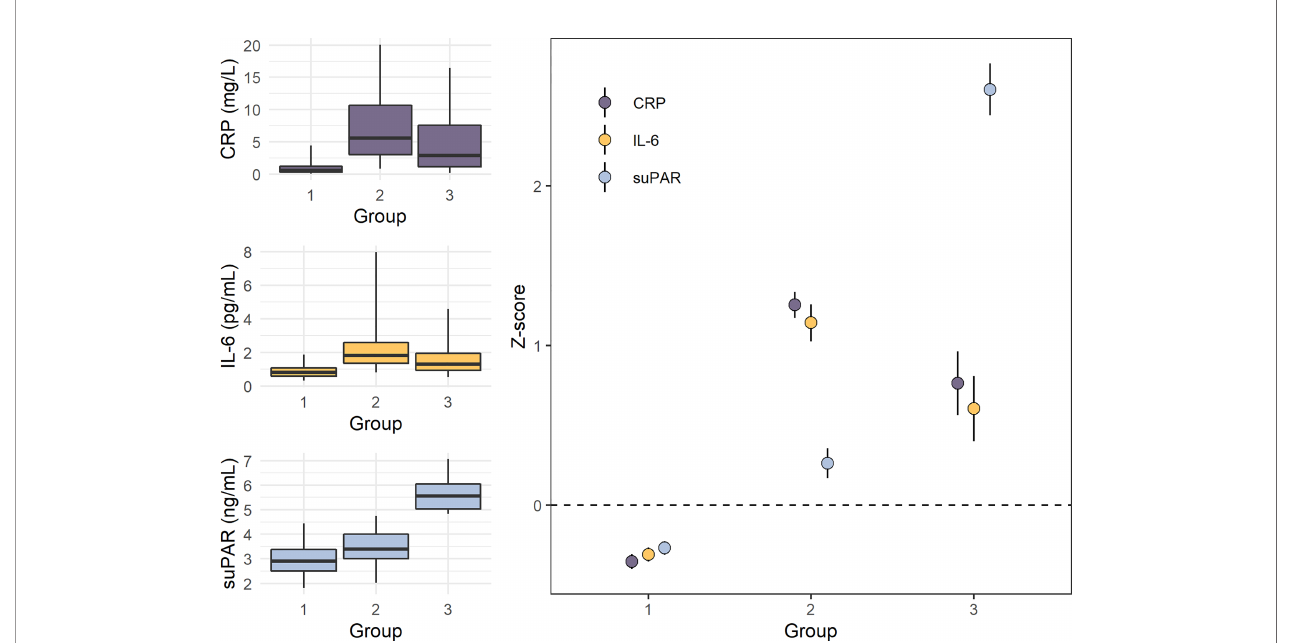
FIGURE 5 | Levels of CRP, IL-6, and suPAR in the three in fl ammation groups identi fi ed by latent class analysis in the E-Risk study (n=1,390). Panels on the left show boxplots (box indicates median and interquartile range, and whiskers indicate 95% con fi dence interval) of untransformed C-reactive protein (CRP), interleukin-6 (IL-6), and soluble urokinase plasminogen activator receptor (suPAR) levels in the three groups, while the panel on the right shows mean Z-scores with standard deviations (M=0, SD=1). Group 1 (n=1,057) consisted of individuals with low CRP, IL-6, and suPAR. Group 2 (n=249) consisted of individuals with high CRP and IL-6 and moderately elevated suPAR. Group 3 (n=84) consisted of individuals with elevated CRP and IL-6 and high suPAR. Data from Rasmussen LJH, et al. (2020)